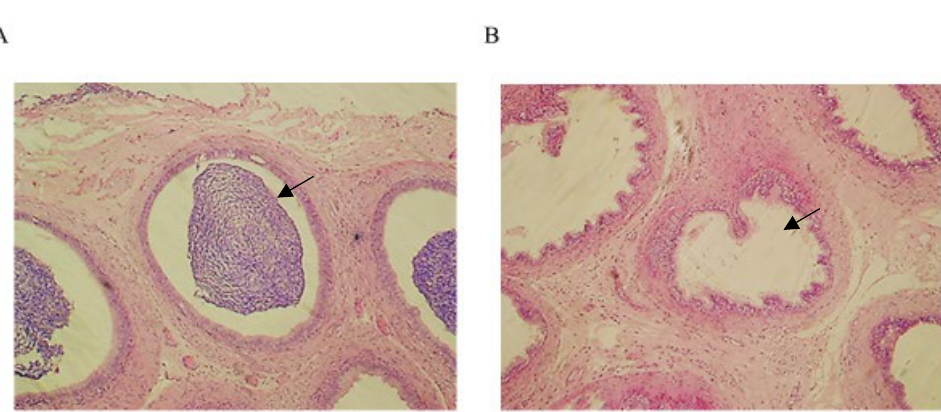
Figure 1. Histological examination of the epididymis in yaks and cattle-yaks. Magnification: 40× (images ( A , B )). ( A ) Sections of HE-stained yak epididymis. ( B ) Sections of HE-stained cattle-yak epididymis. The arrow points to the epididymal canal.